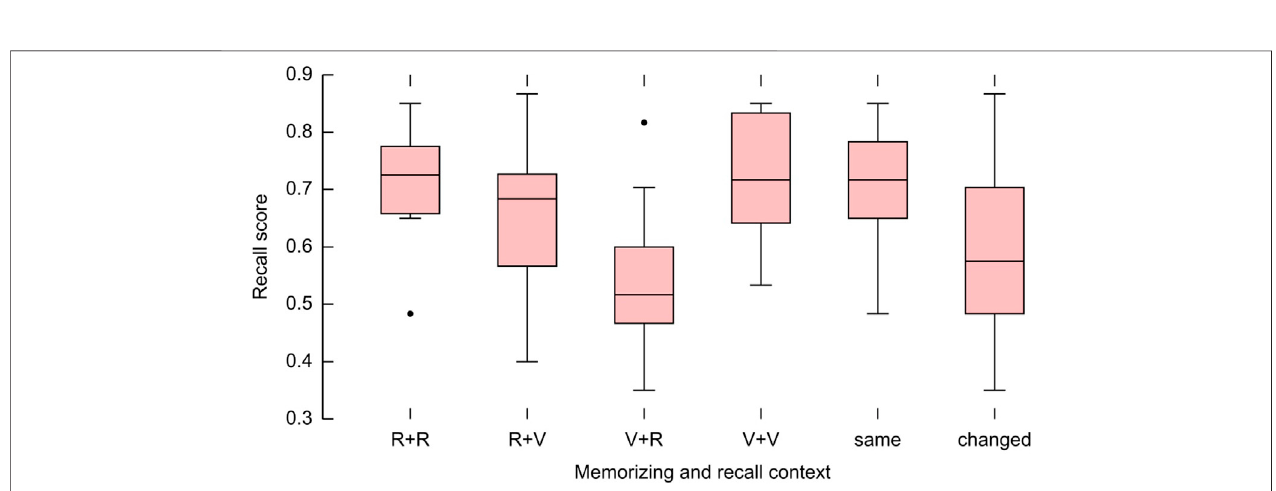
FIGURE 4 | Boxplots of recall scores for different sub-samples that are de fi ned by their memorizing and recall context conditions (detailed values in Table 4 ).